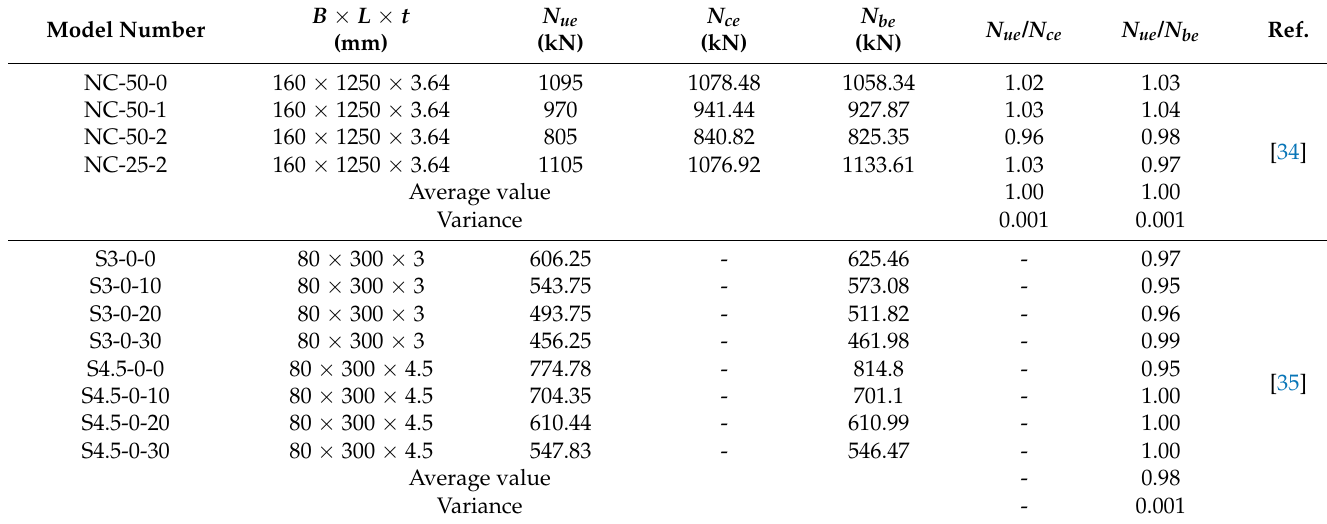
Table 2. Numerical modelling results of specimens with acid rain